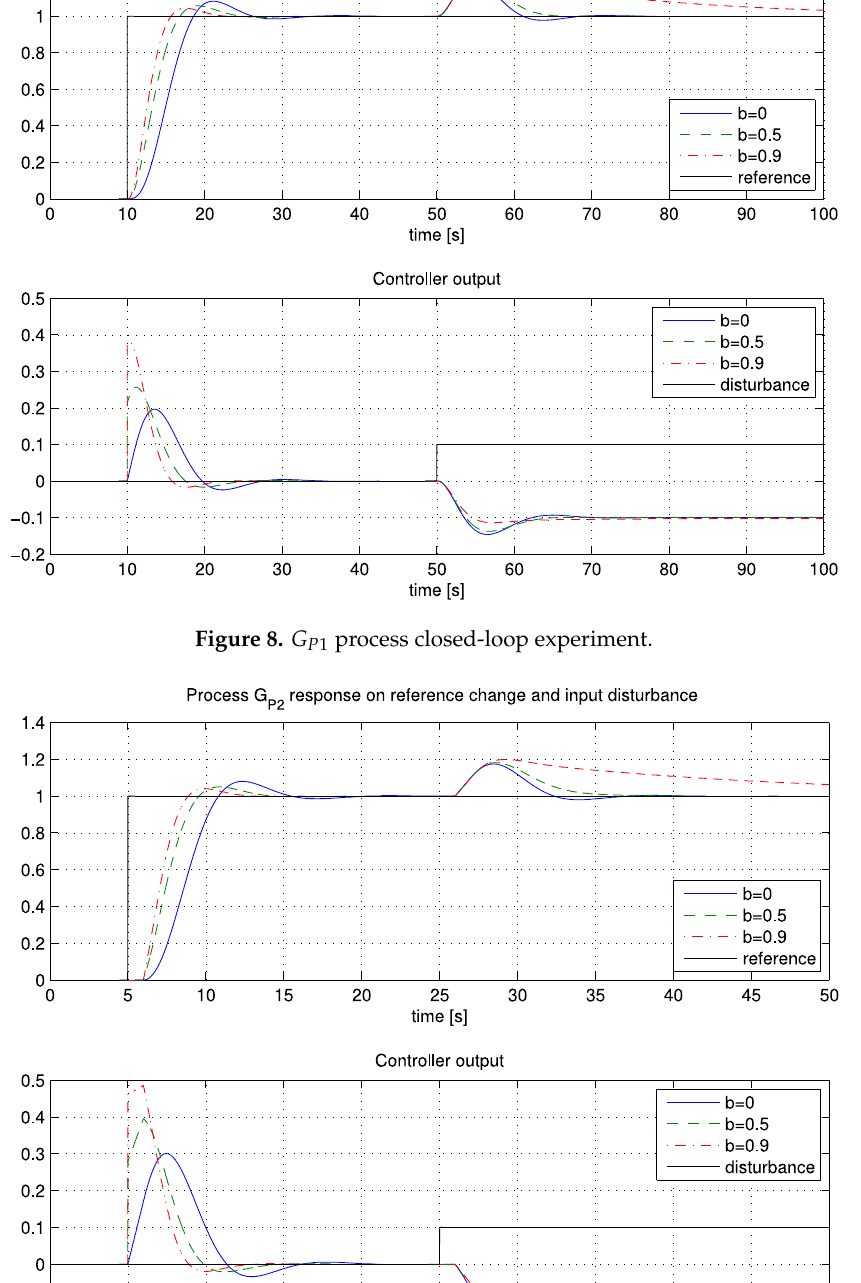
Figure 10. G P 3 process closed-loop experiment.